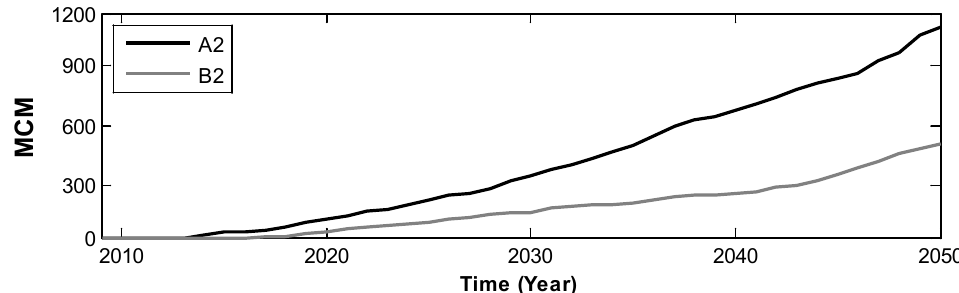
Fig. 5 Total unmet water demand based on the A2 and B2 Scenarios using WEAP